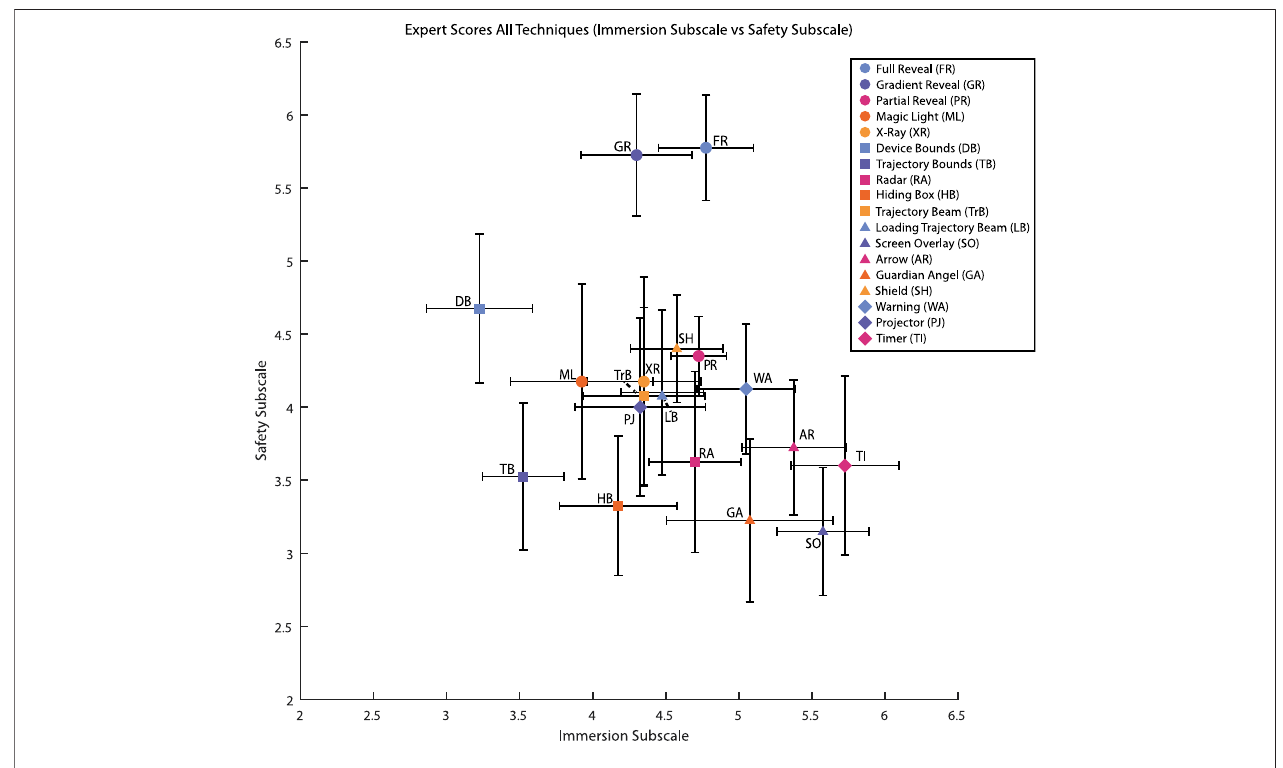
FIGURE 9 | Overall average scores for the Safety and (PC1) and Immersion (PC2) subscales, for each technique. Axes are cropped in order to display values and 95% con fi dence intervals as clearly as possible. Figure 7 and the accompanying video for seeing the illustrations of the techniques.